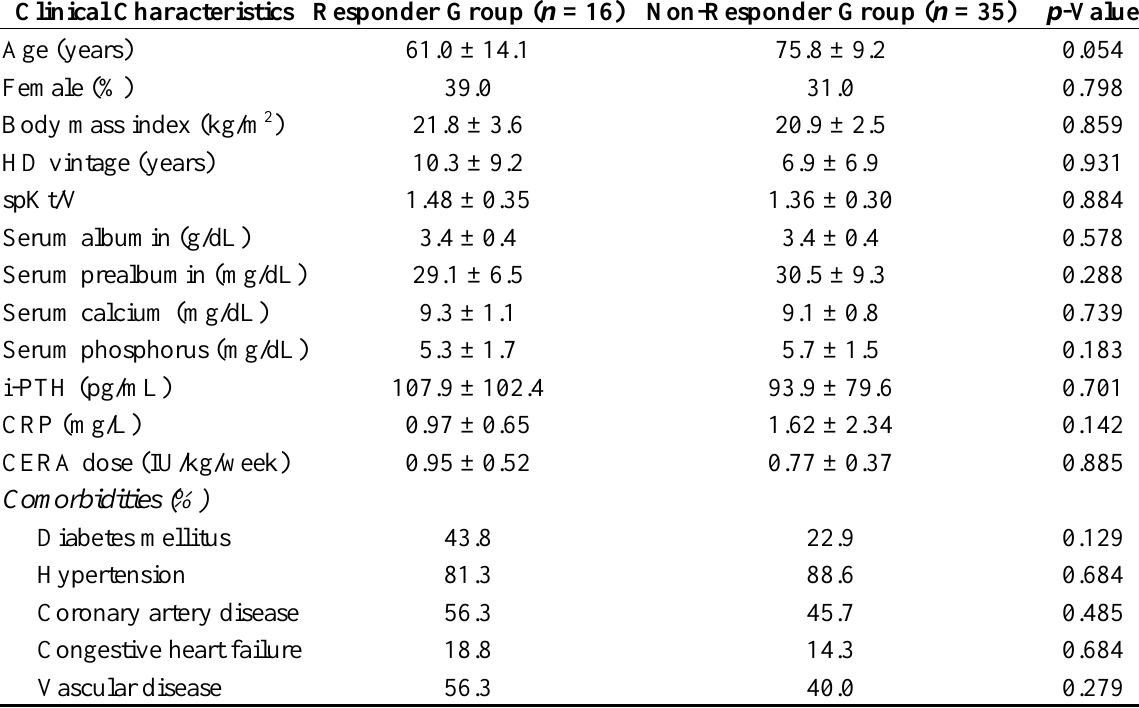
Table 1. Baseline characteristics of the study population.